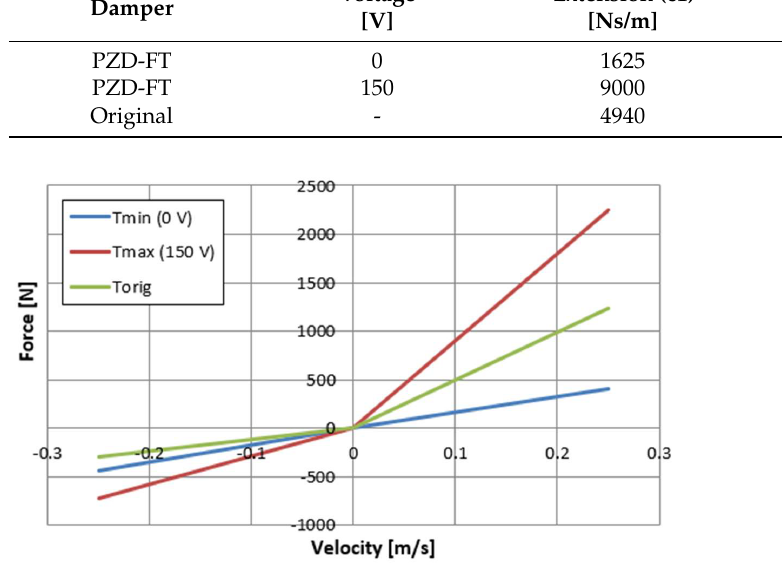
Figure 10. Model characteristics of the PZD-FT shock absorber on the damping force-velocity plane: Tmin (0 V) (blue)—PZD without supplying voltage (0 V), Tmax (150 V) (red)—PZD with supplying voltage (150 V), Torig (green) factory passive damper.